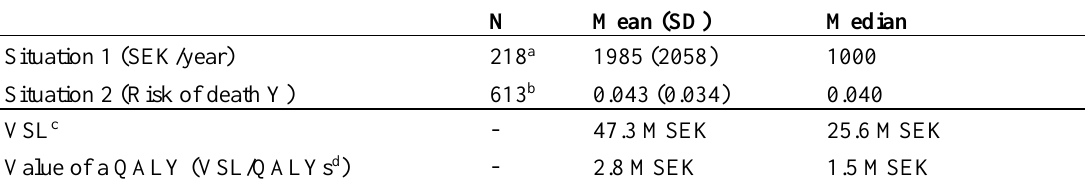
The value of a statistical life (VSL) and the value of a QALY in the context of blood-borne diseases based on the answers to situation 1 and 2 (the chained approach N Mean (SD) Median Situation 1 (SEK/year) 218 a 1985 (2058)